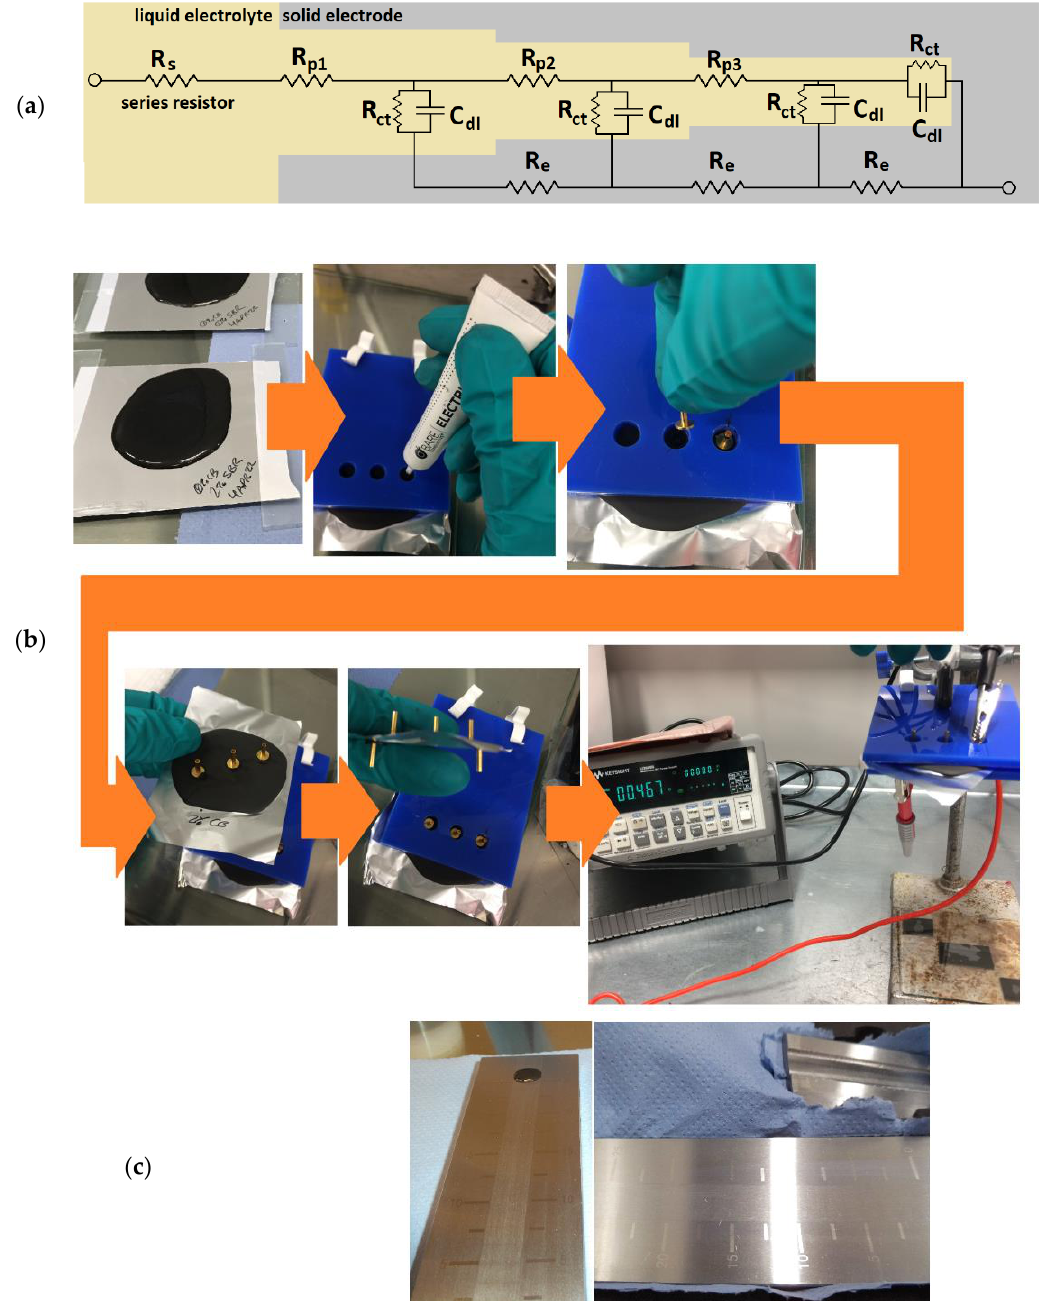
Figure 2. Methods applied herein: ( a ) equivalent circuit of un-sodiated porous hard carbon electrodes; ( b ) slurry slab preparation showing the custom stencil; and ( c ) Hegman gauge and blade before sweeping a sample. R p1–3 represents the pore resistances, R e represents the resistance in a solid electrode, R ct represents the charge transfer resistance and C dl represents the double-layer capaci- tance.